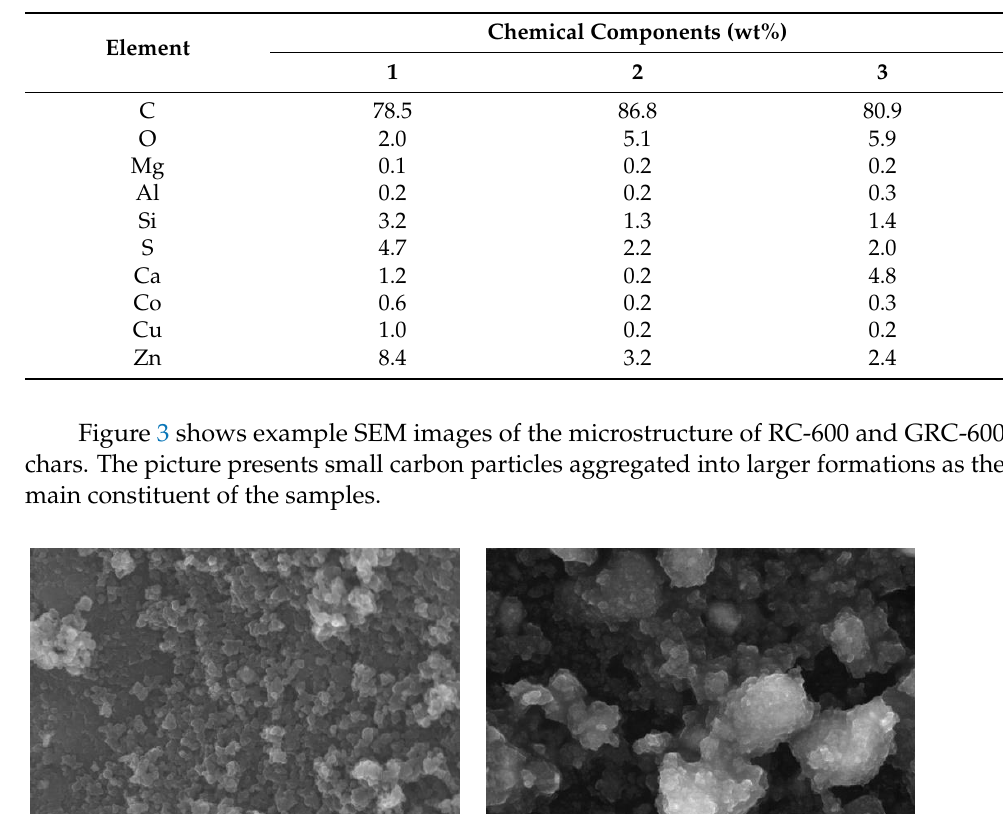
Figure 2. SEM image of RC-600. Table 4. Analysis EDS of selected points of RC-600. Table 4. Analysis EDS of selected points of RC-600.